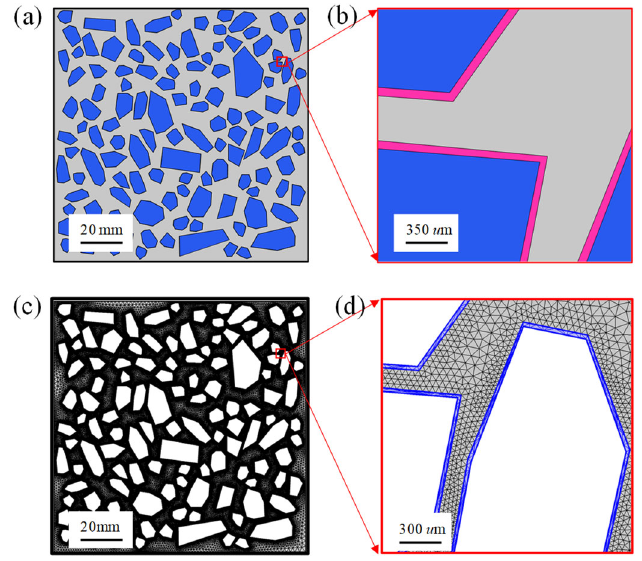
Figure 5. Schematic of 2D multi ‐ phase meso structure of concrete. ( a ) Meso ‐ structure of concrete, ( b ) local magnification of the meso ‐ structure, ( c ) finite element mesh, and ( d ) local magnification of the finite element mesh, respectively.